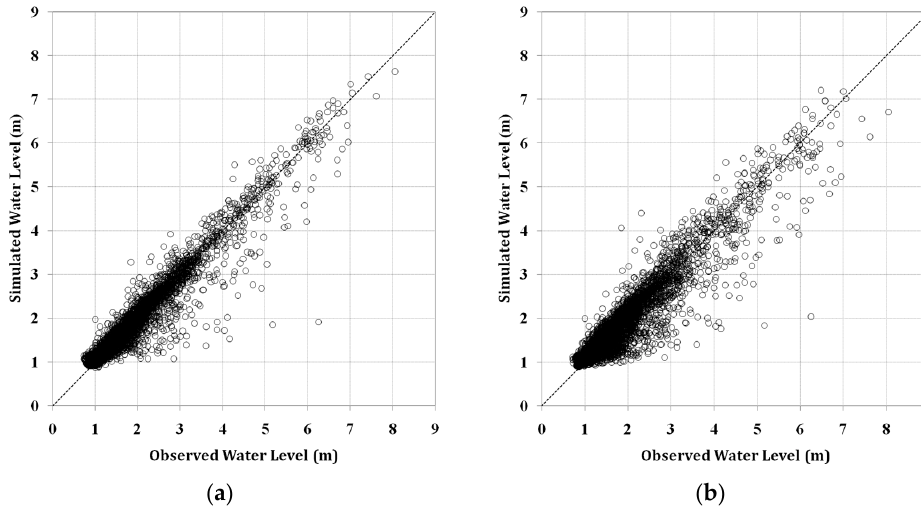
Figure 15. Scatter plots of observed and forecasted water levels with a lead-time of 3 h. ( a ) ANN3c; ( b ) ANN3a.